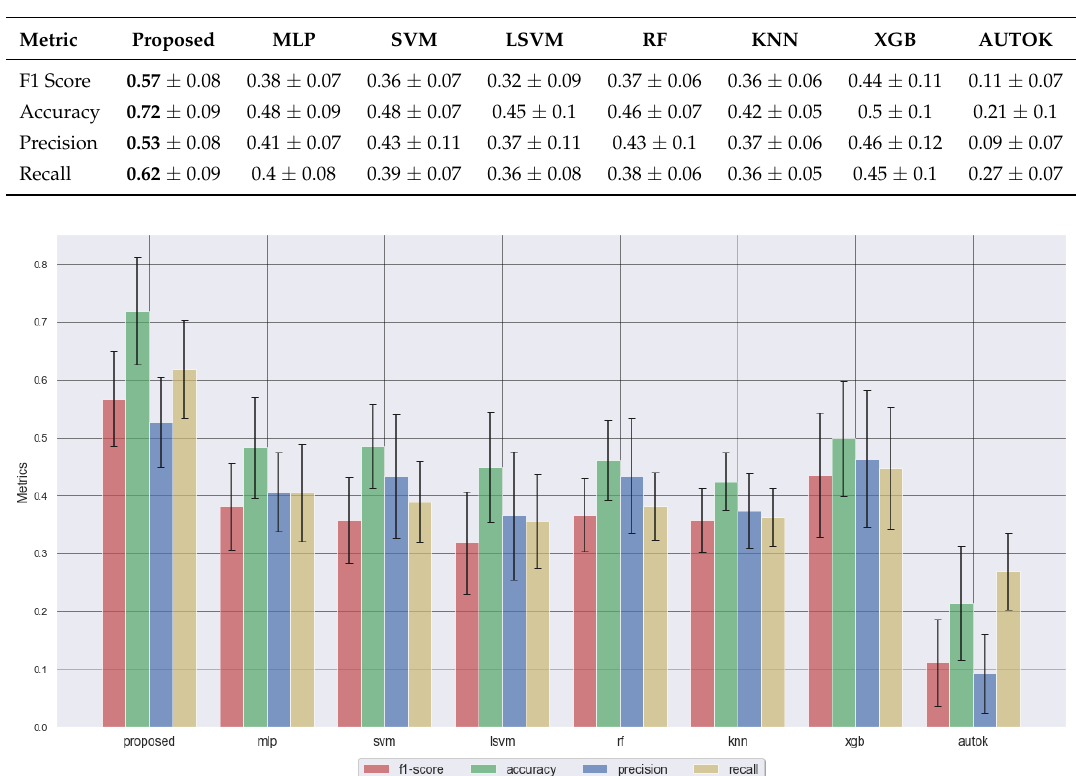
Table 2. Cross-subject results.